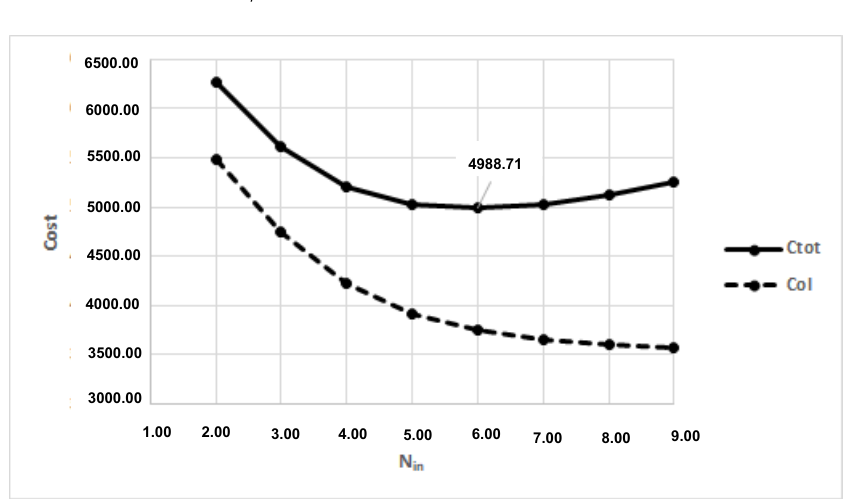
Figure 6. Variations of C p + C i and C c per N in .